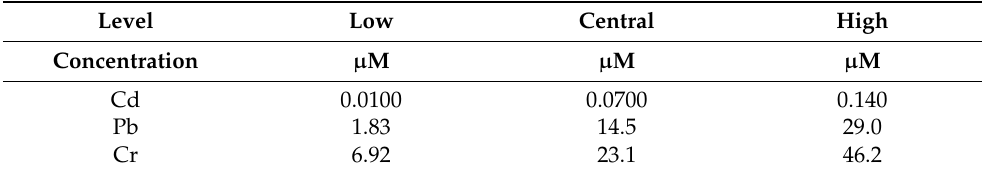
Table 1. Metals concentrations corresponding to countryside (low), urban (central) and heavily polluted soil (high) utilized for the